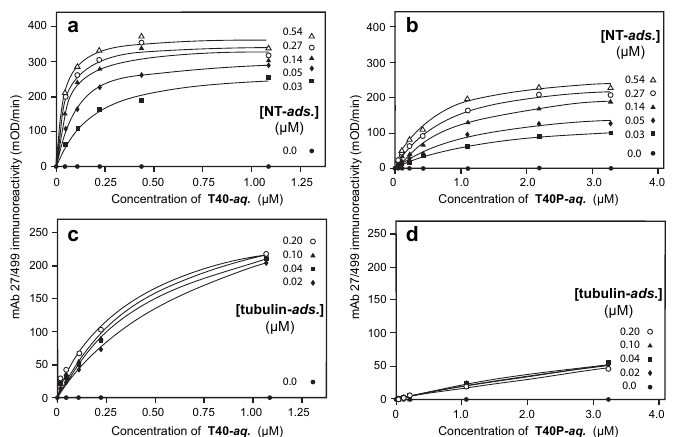
Figure 4. Intrinsic inhibitory effects of phosphorylation. Binding of T40 and T40P in the aqueous-phase to adsorbed neonatal tau (“NT”; ( a , b )) or adsorbed depolymerised bovine tubulin ( c , d ) at the plating concentrations indicated. Although NT in the aqueous-phase did not bind to solid-phase dGA (data not shown), binding of T40 (a) to NT was indistinguishable from that seen with dGA in the solid-phase. Binding was inhibited by a factor of 24-fold following in vitro hyperphosphorylation of recombinant tau (“T40P”; (b)). Binding of recombinant human tau to depolymerised bovine tubulin (c) was likewise inhibited by a factor of 24-fold following hyperphosphorylation of tau in vitro (d). Tau binding was detected using mAb 27/499.